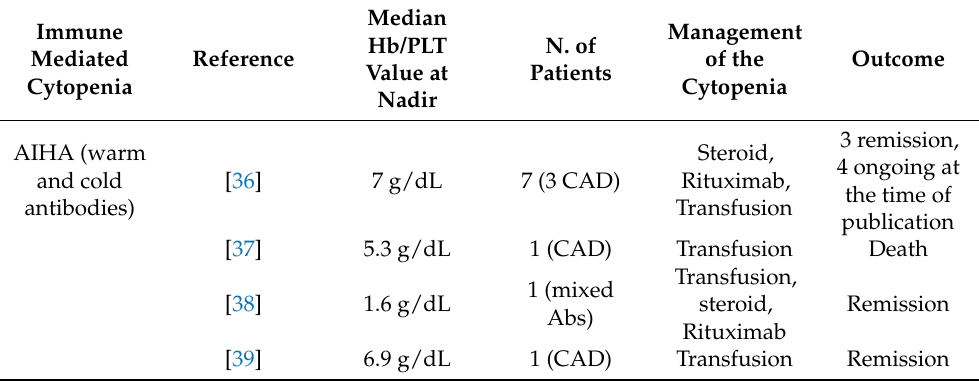
Table 2. Immune-mediated cytopenia triggered by